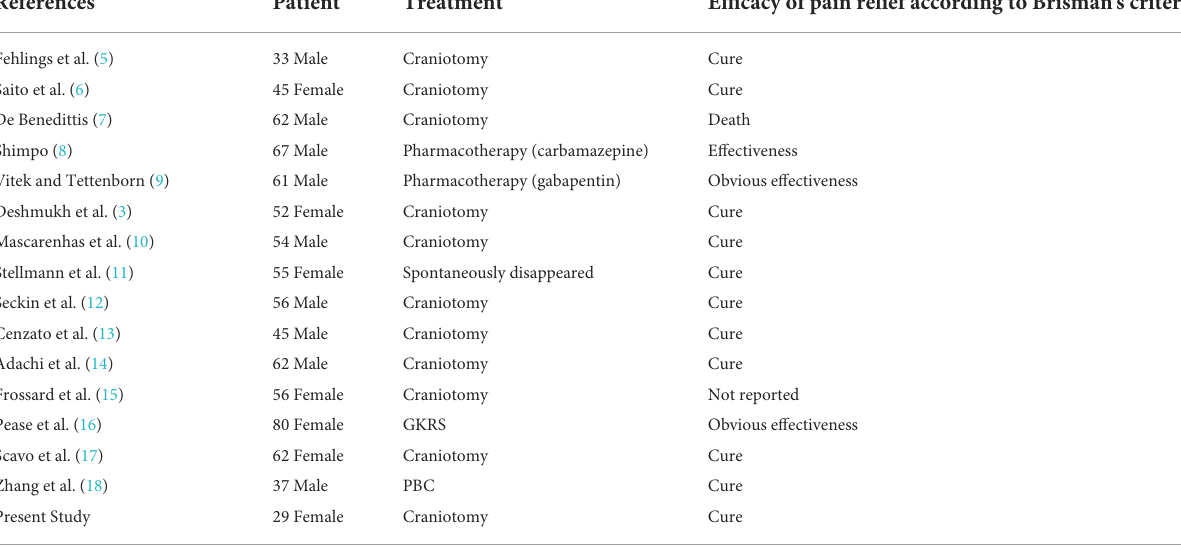
TABLE 1 Reported cases of Cavernous malformation with Trigeminal